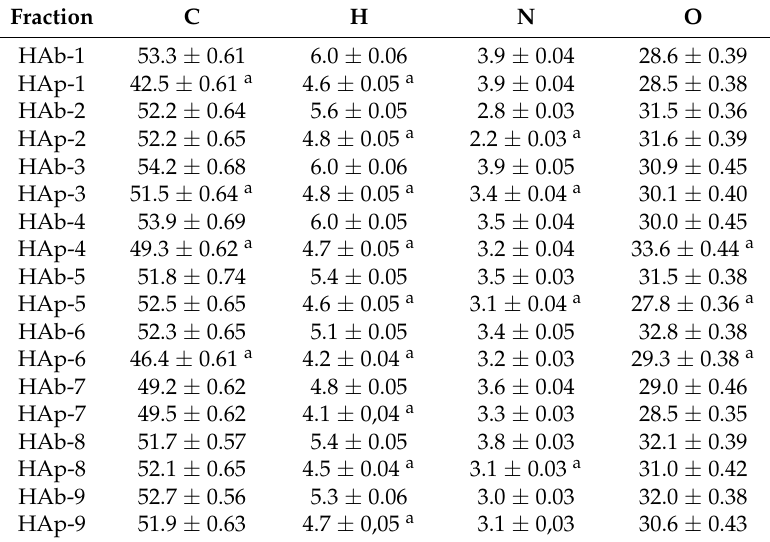
Table 2. Elemental composition of the HA fractions expressed as weight percent.